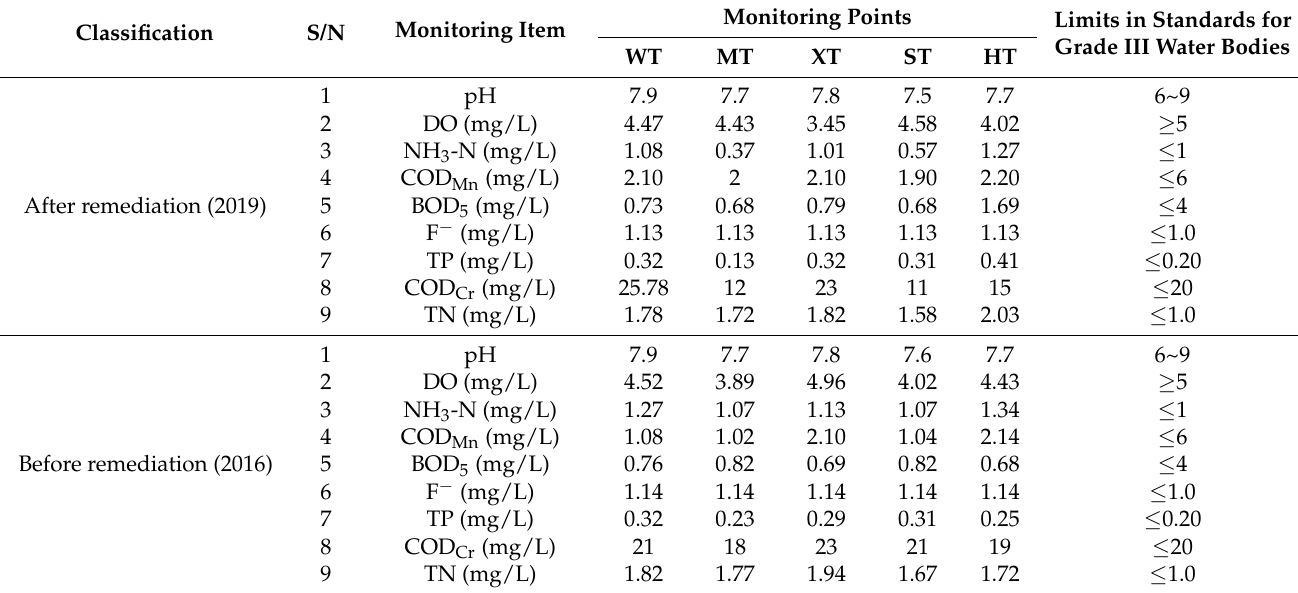
Table 4. Comparison of changes in pollutant concentrations and statistics of water